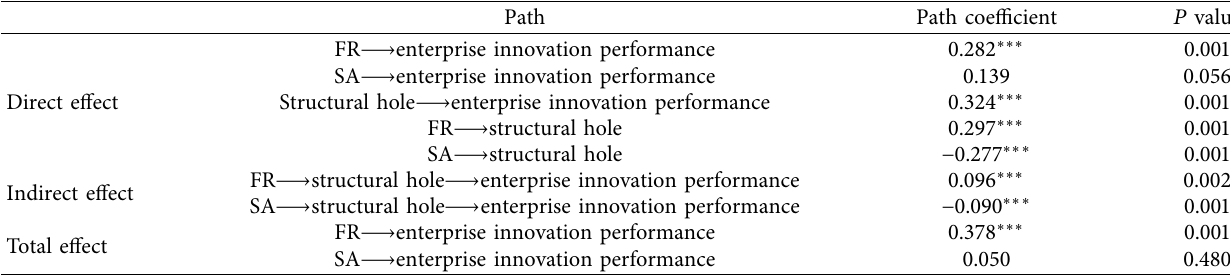
Table 7: Test results of structural equation